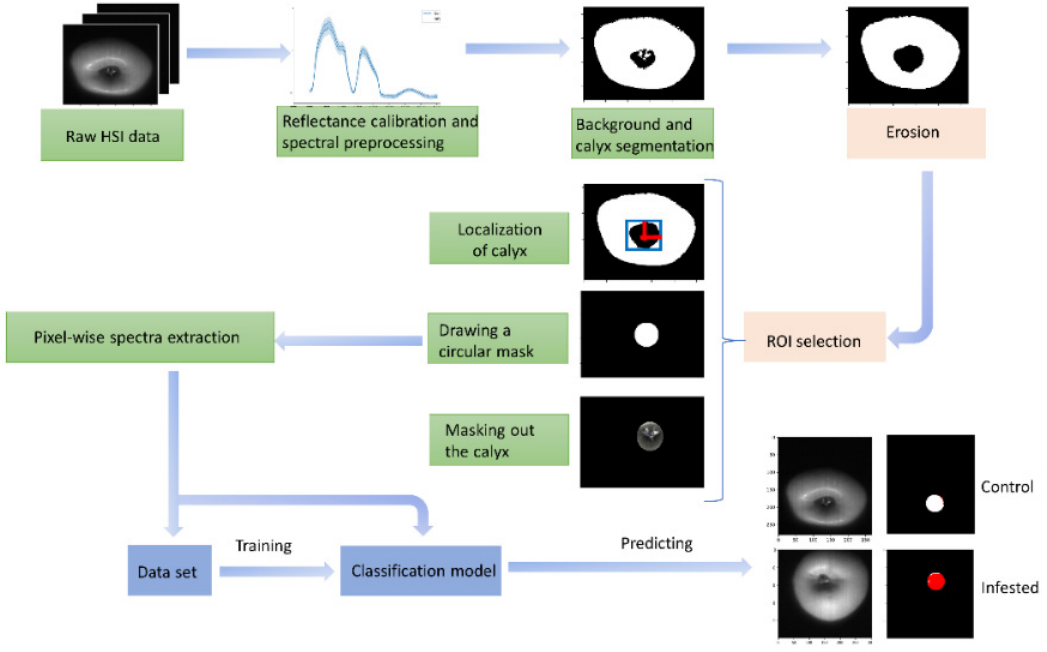
Figure 2. Flowchart of apple infestation area acquisition around calyx end for building the classification model. HIS: hyperspectral imaging; ROI: region of interest.